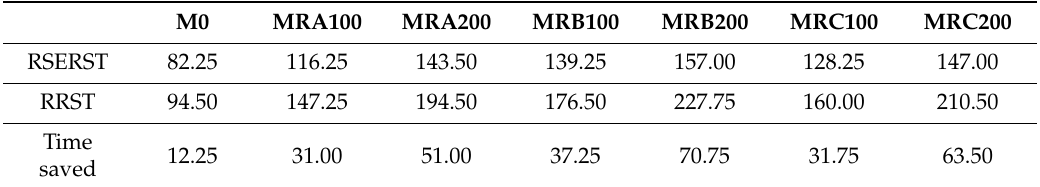
Table 7. Cracking time of RSERST and RRST specimen (h).